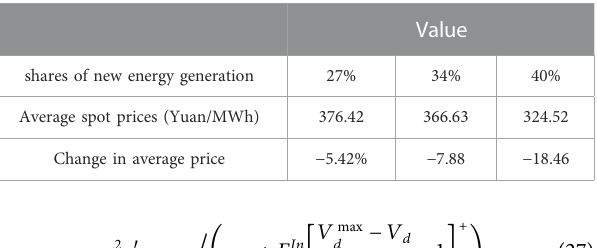
TABLE 3 Average spot prices for markets with different shares of new energy